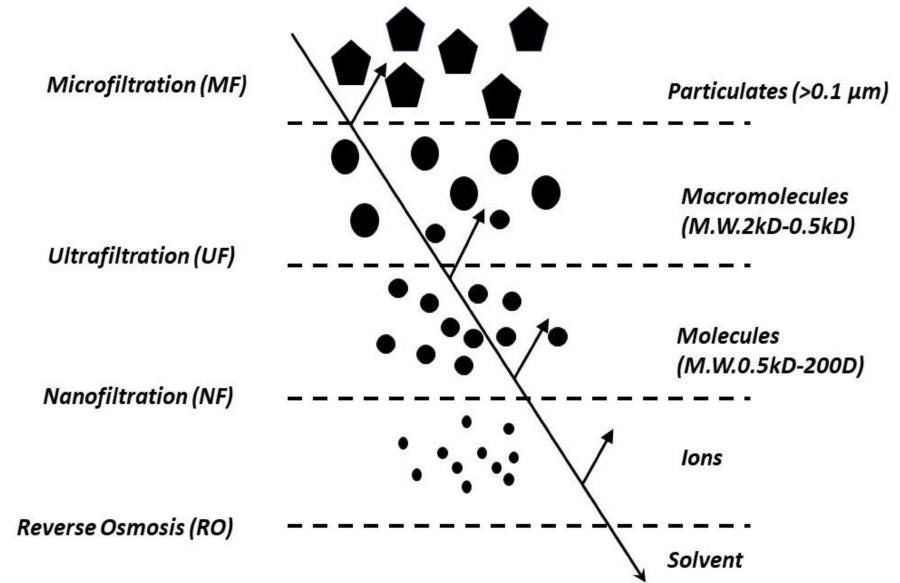
Figure 1. Schematic representation of microfiltration (MF), ultrafiltration (UF), nano filtration (NF) and reverse osmosis (RO) separation principles